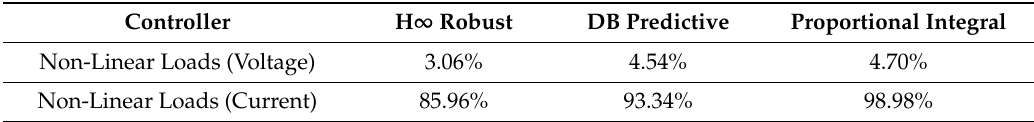
Figure 11. Simulation results with the PI controller in steady-state condition. ( a ) Output voltage, ( b ) Load current, ( c ) THD value of voltage, ( d ) THD value of current. Table 4. Voltage and current THD values at steady-state condition with non-linear loads. Controller H ∞ Robust DB Predictive